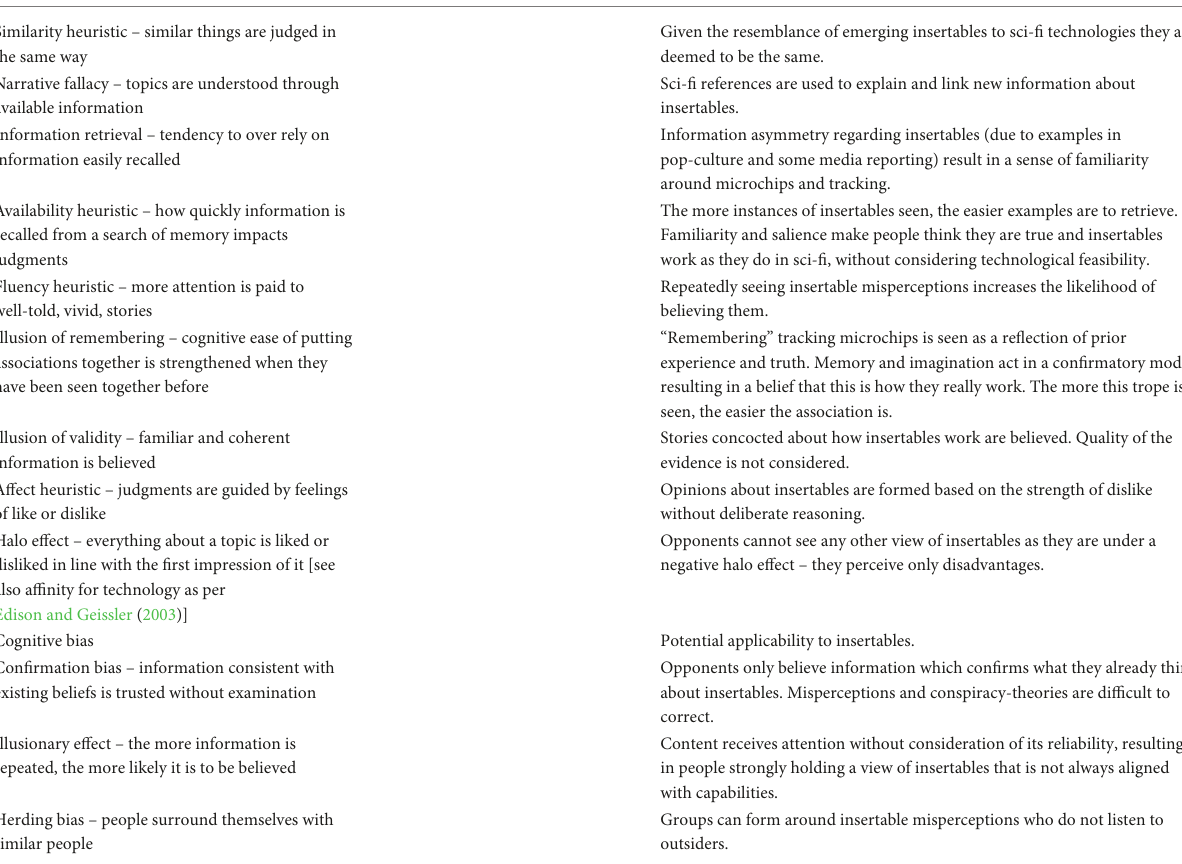
TABLE 3 Cognitive bias influence on insertable-device